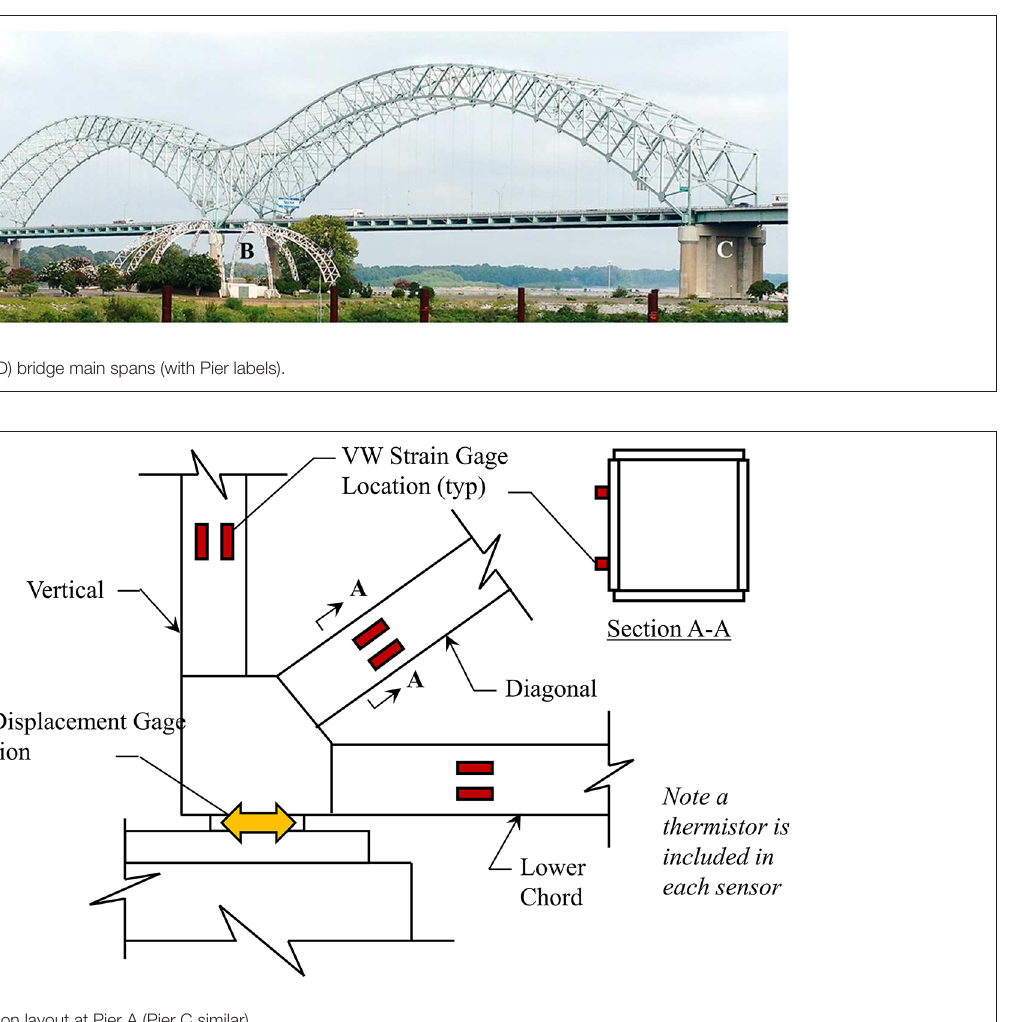
FIGURE 6 | General instrumentation layout at Pier A (Pier C